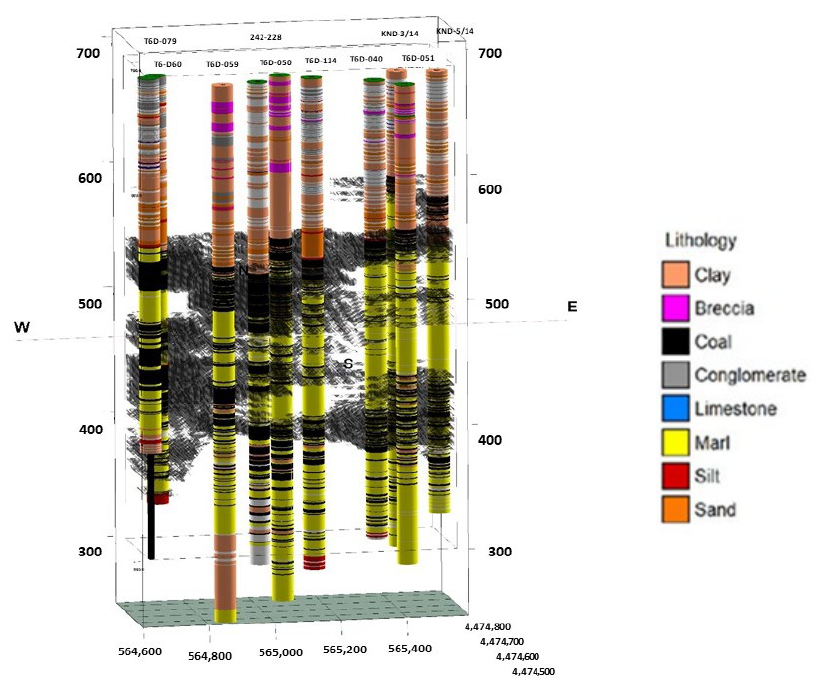
Figure 13. 3D diagram of interpolated lignite layer (black color) correlated with lithogical boreholes regarding lithological model with Vertical Exaggeration x4. Vertical axis represent elevation above sea level (a.s.l) values.